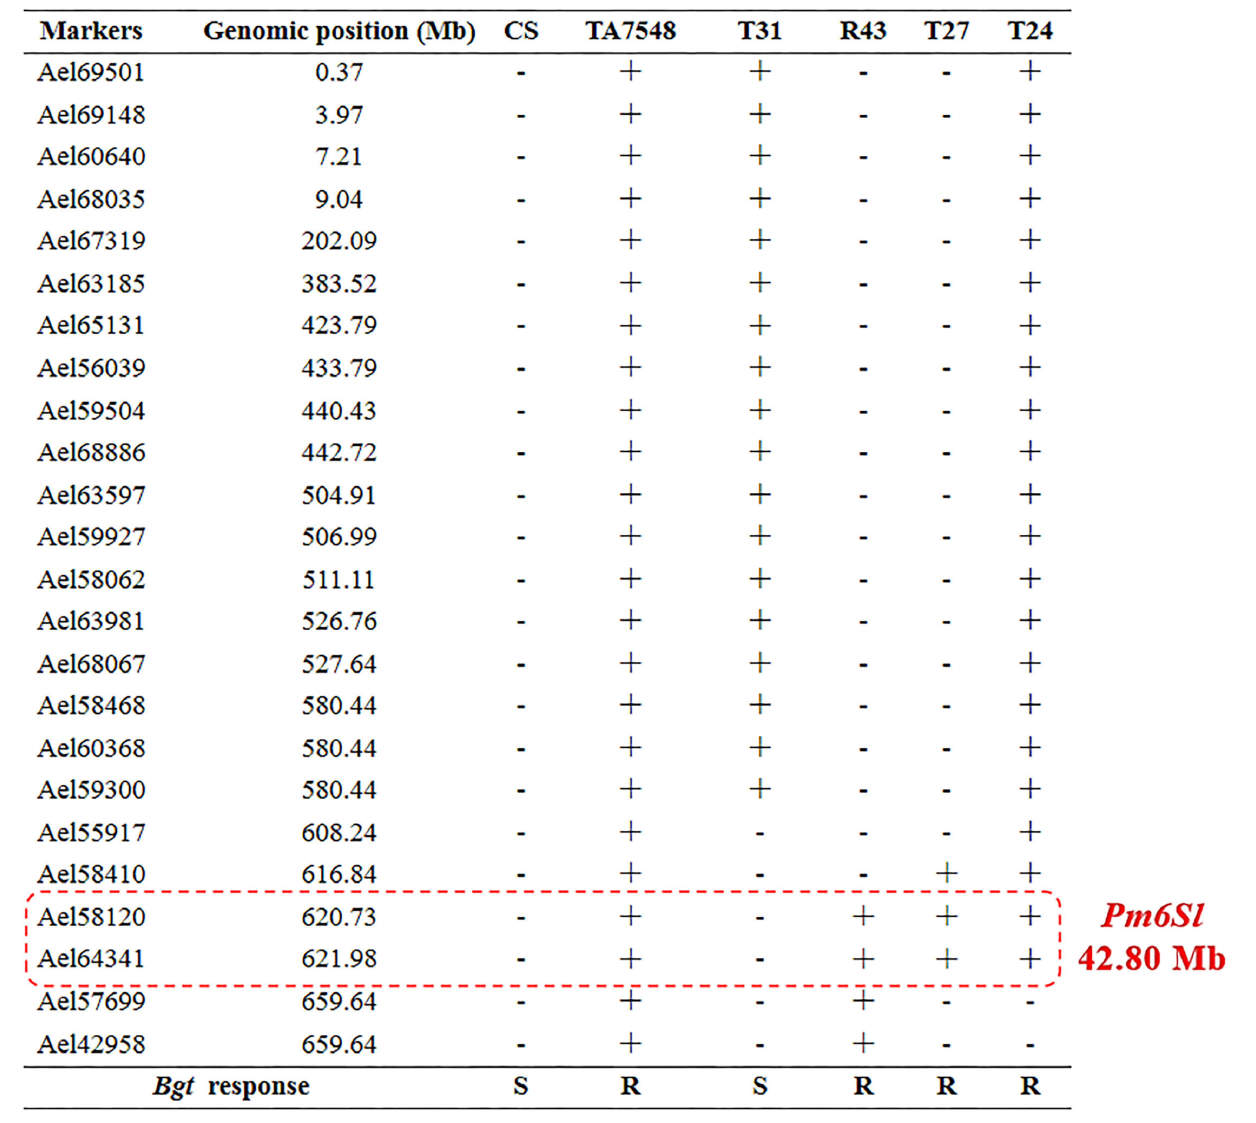
FIGURE 7 | Physical mapping of gene Pm6Sl . “ + ” indicated the presence of 6S l #3-specific molecular markers, “ – ” indicated the absence of 6S l #3-specific molecular marker. R indicated resistance to powdery mildew, S indicated susceptible to powdery